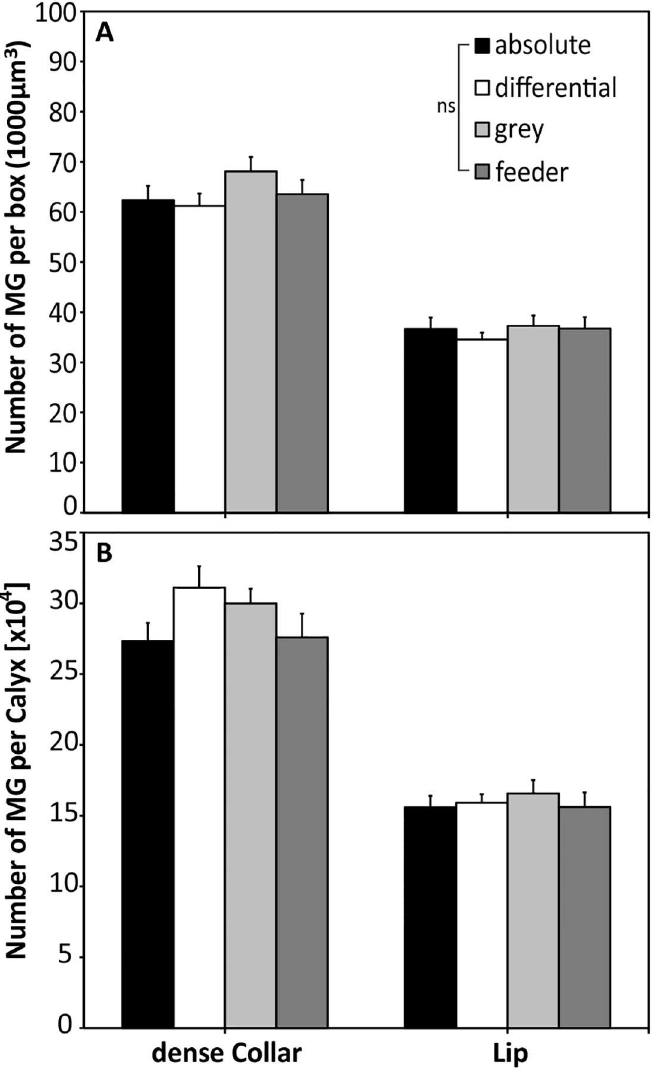
Fig 5. Number of microglomeruli per cube (10x10x10 μ m in size, A) and extrapolated number of MG per calyx (B). No differences in MG numbers were found among groups in any region (dense collar, lip), either when counted per cube or extrapolated to the total number (per calyx). ns: not significant; absolute: N = 13; differential: N = 14; grey: N = 10; feeder: N = 10. Z = -0.666; grey control: P = 0.664, Z = -0.434; feeder control: P = 0.162, Z = -1.398). Between experimental groups, no significant differences were found in the number of MG per 1000 μm 3 for the lip (P = 0.745, chi 2 = 1.231; absolute: 36.6 ± 2.3 MG/box; differential: 34.5 ± 1.4 MG/ box; grey control: 37.3 ± 2.0 MG/box; feeder control: 36.7 ± 2.3 MG/box) or the dense collar region (P = 0.266, chi 2 = 3.955; absolute: 62.4 ± 2.8 MG/box; differential: 61.2 ± 2.5 MG/box; grey control: 68.1 ± 2.9 MG/box; feeder control: 63.5 ± 2.9 MG/box; Fig 5A). Estimation of total MG numbers in the lip and dense collar regions also revealed no significant differences among groups, neither for the lip (P = 0.926, chi 2 = 0.466; absolute: 15.6 ± 0.8 x 10 4 MG/calyx; differential: 15.9 ± 0.6 x 10 4 MG/calyx; grey control: 16.6 ± 0.9 x 10 4 MG/calyx; feeder control: 15.6 ± 1.0 x 10 4 MG/calyx), nor for the collar (P = 0.310, chi 2 = 3.587; absolute: 27.3 ± 1.3 x 10 4